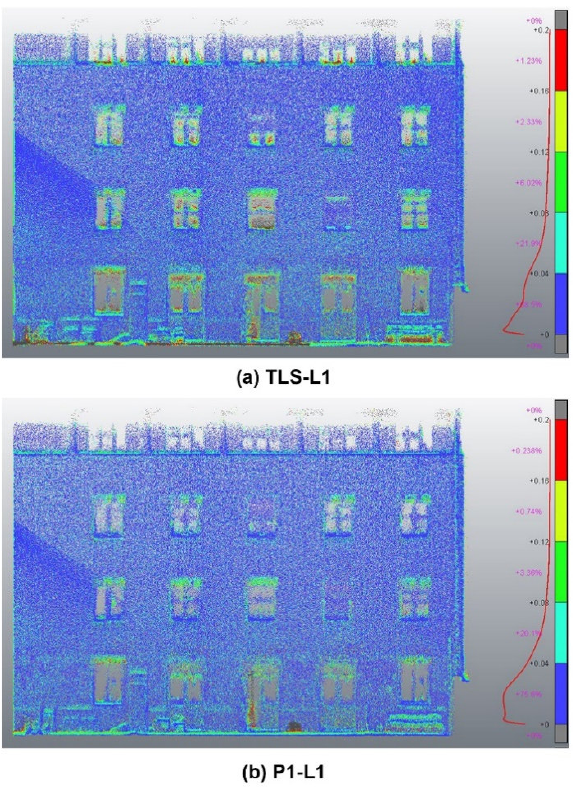
Figure 5. C2C analyses of the west facade. TLS (a) and P1 (b) are used as ground reference and L1 as compared dataset.